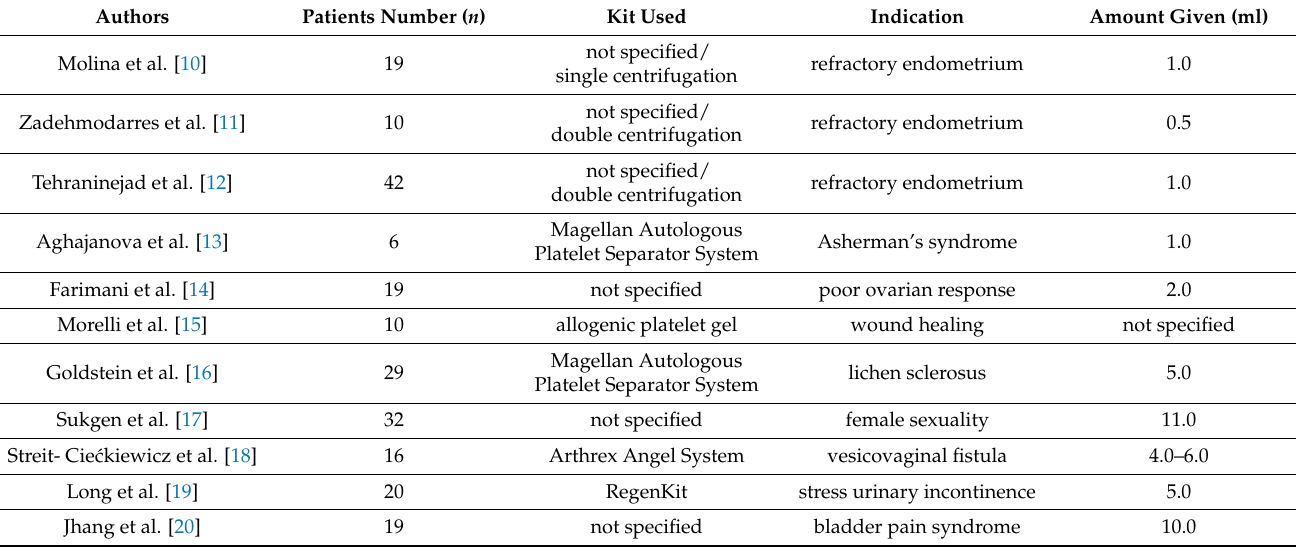
Table 3. Summary of selected articles and PRP preparation